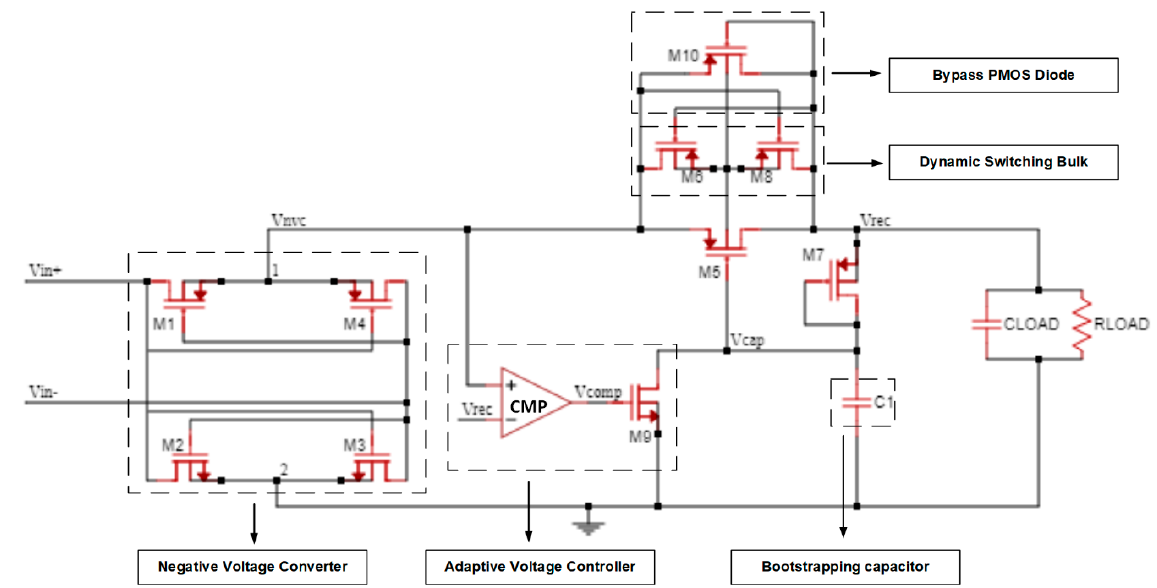
Figure 1. Schematic of the proposed active rectifier composed by a NVC and an active diode controlled by a threshold cancellation circuit.